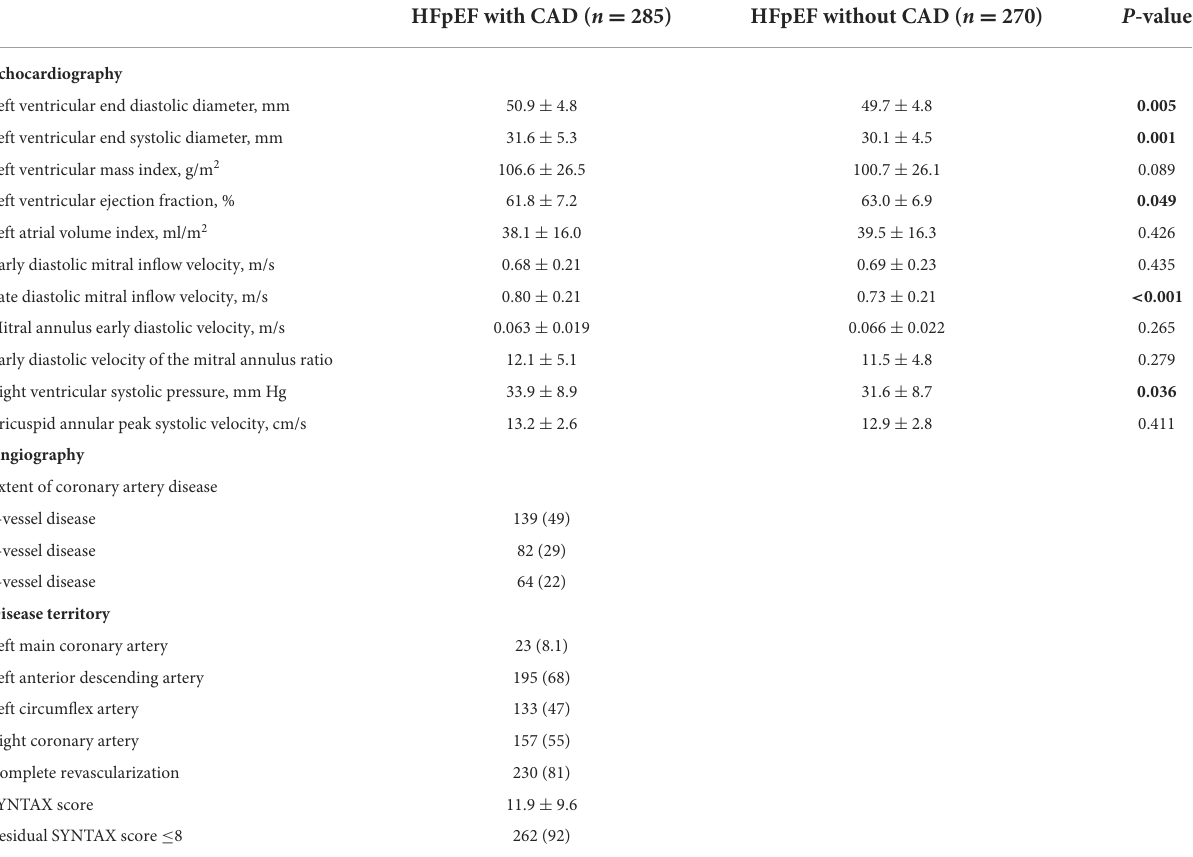
TABLE 2 Echocardiographic and angiographic evaluation. HFpEF with CAD ( n = 285) HFpEF without CAD ( n = 270) P